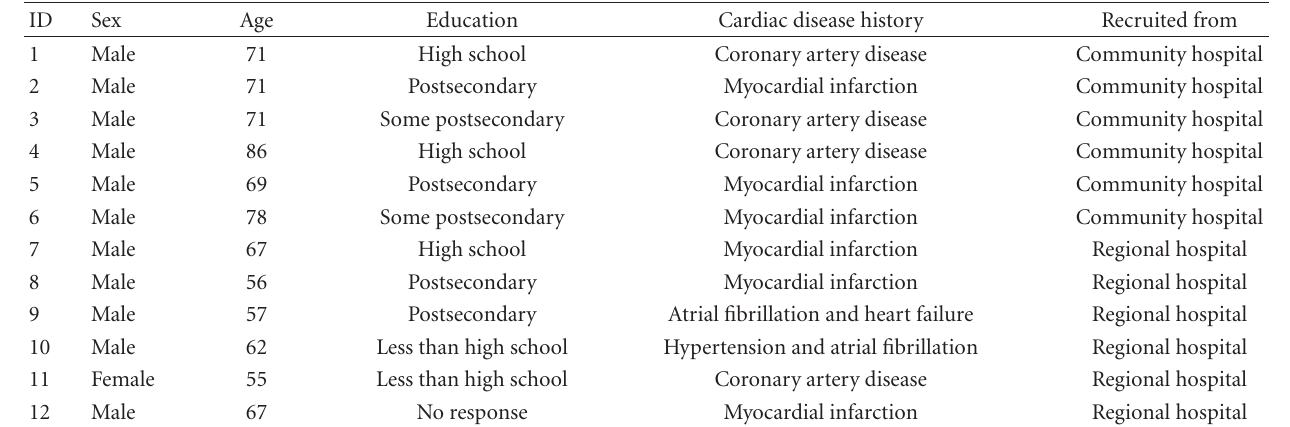
Table 2: Patient participant